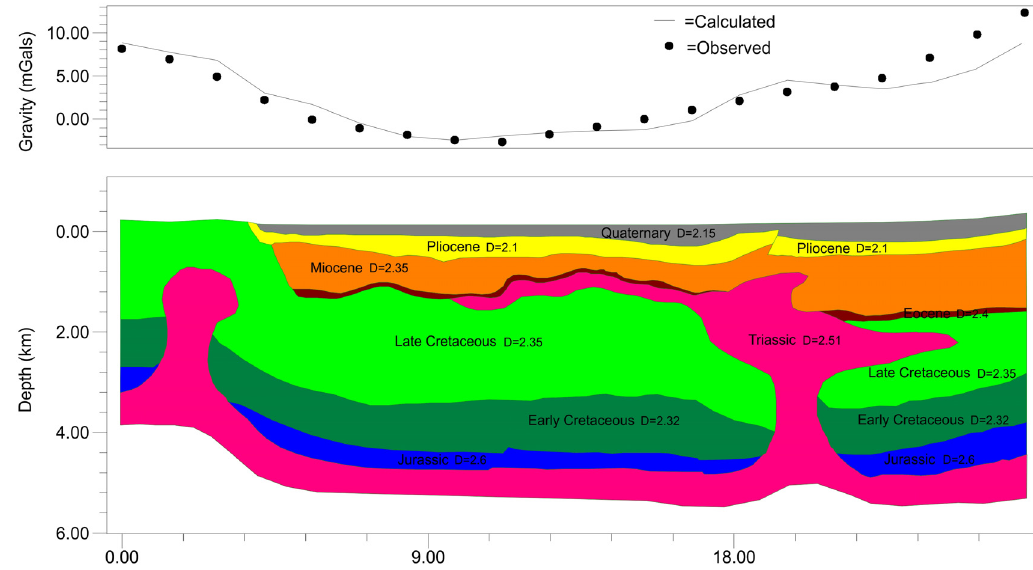
Figure 11. Two dimensional model (2D) along NW–SE section in the Medjerda Valley Plain, showing a diapir Triassic structure with lateral outpouring at the center of the